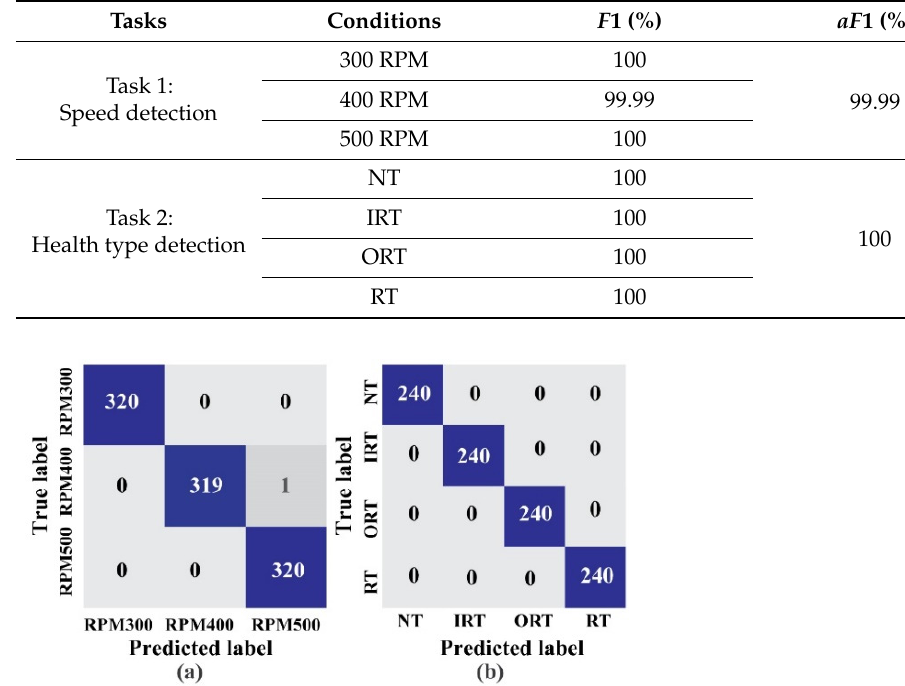
Table 3. Diagnostic performance of the dataset.